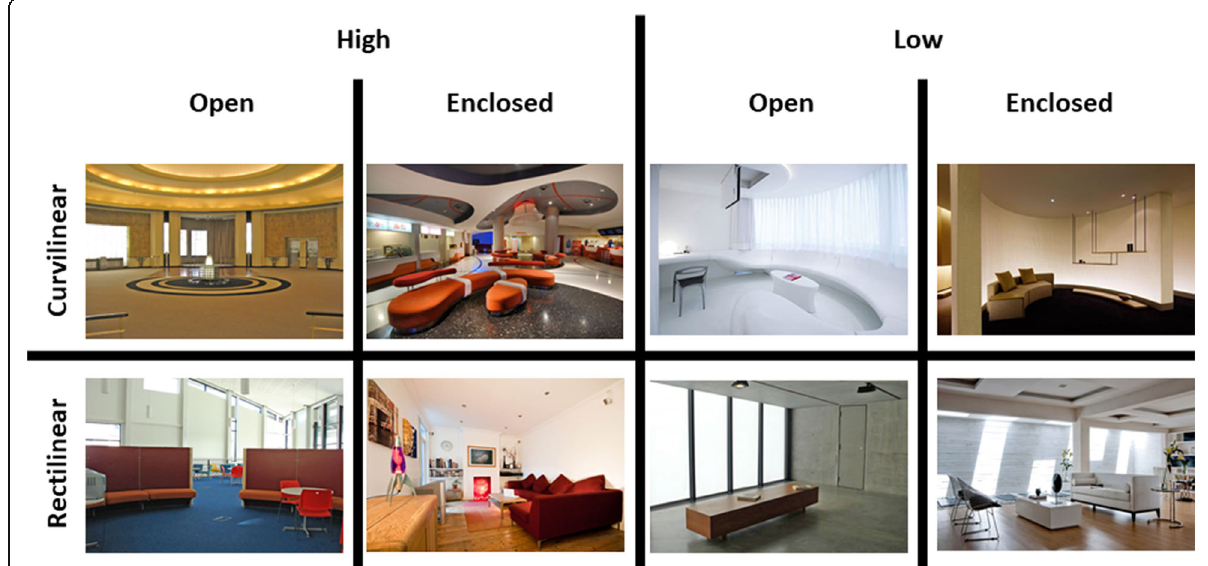
Fig. 3 A selection of the interiors shown to participants in a neuroimaging study designed to assess viewers ’ approach-avoidance motivation in response to curvilinear vs. rectilinear spaces. [High/Low roof; Open/Enclosed space.] [Figure reprinted with permission from Vartanian et al.,